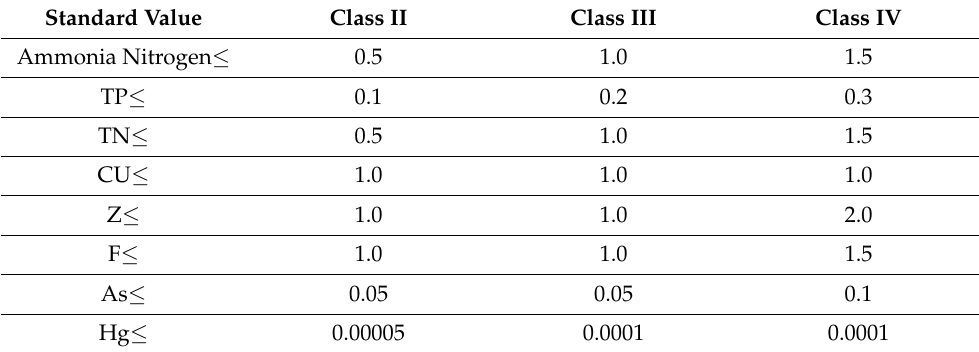
Table 1. Standard limits for basic items of environmental quality standards for surface water.